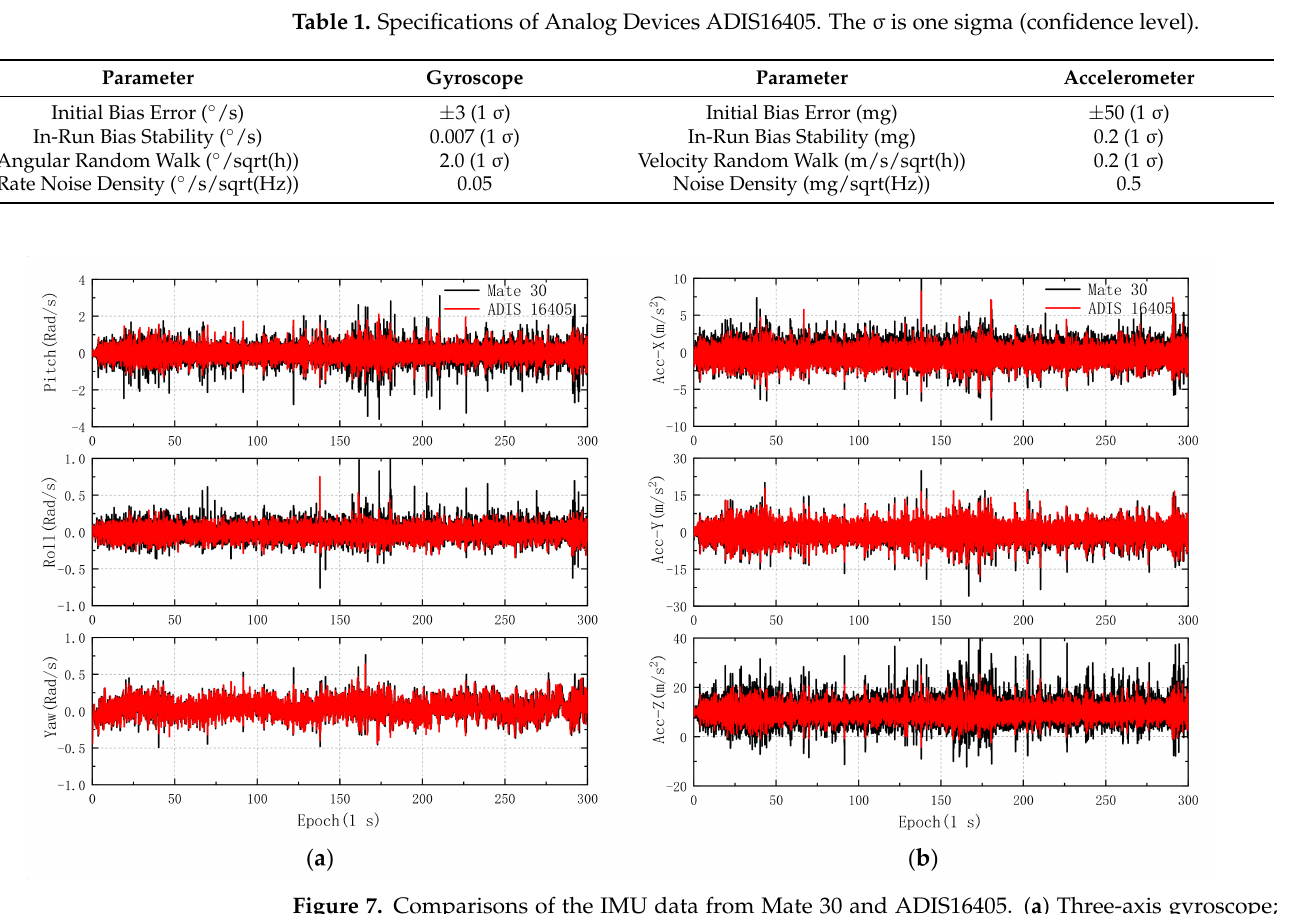
Figure 7. Comparisons of the IMU data from Mate 30 and ADIS16405. ( a ) Three-axis gyroscope; ( b ) three-axis